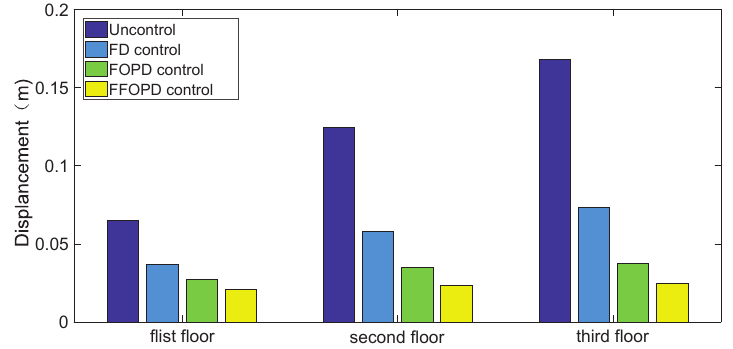
Figure 17. Maximum displacement of each floor under El-Centro earthquake.